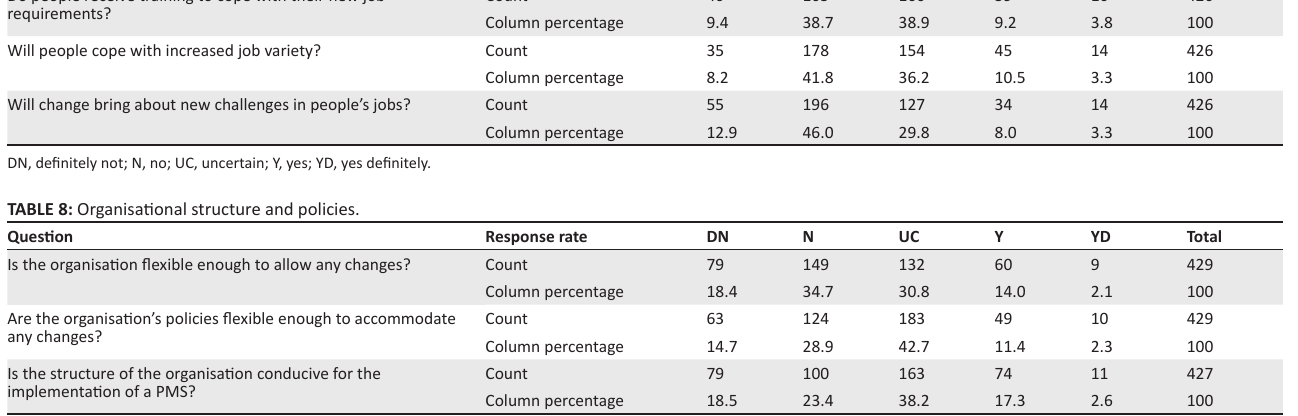
TABLE 7: Training provided by organisation. Question